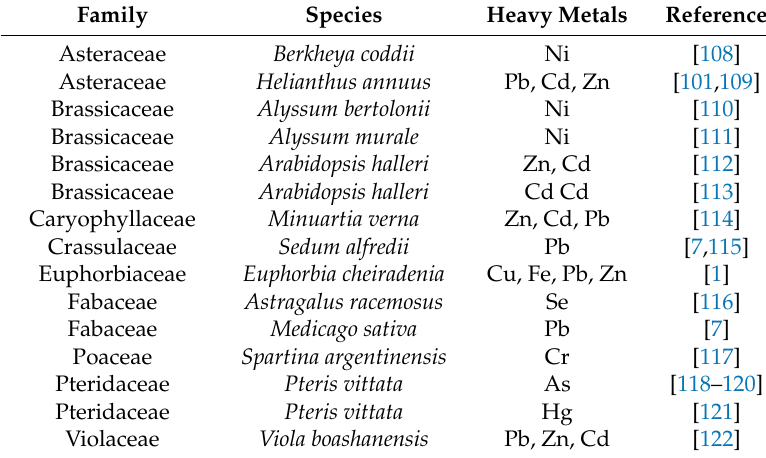
Table 2. Some hyperaccumulator plants used in phytoextraction of heavy metals. Family